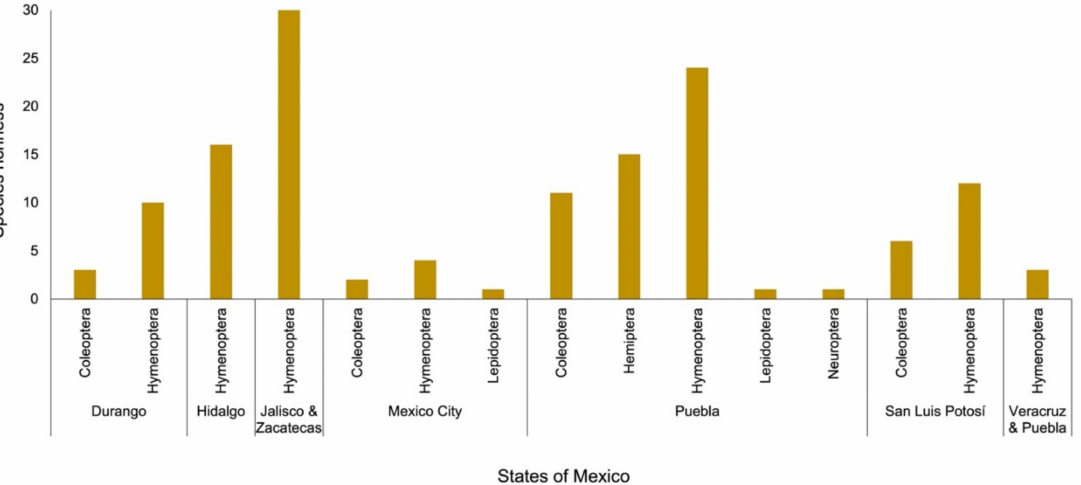
Figure 5. Number of insect species in each order that have been recorded as associated with flowers of Opuntia species in retrieved articles published in academic databases, which were organized alphabetically by states in Mexico. Further details are shown in Table